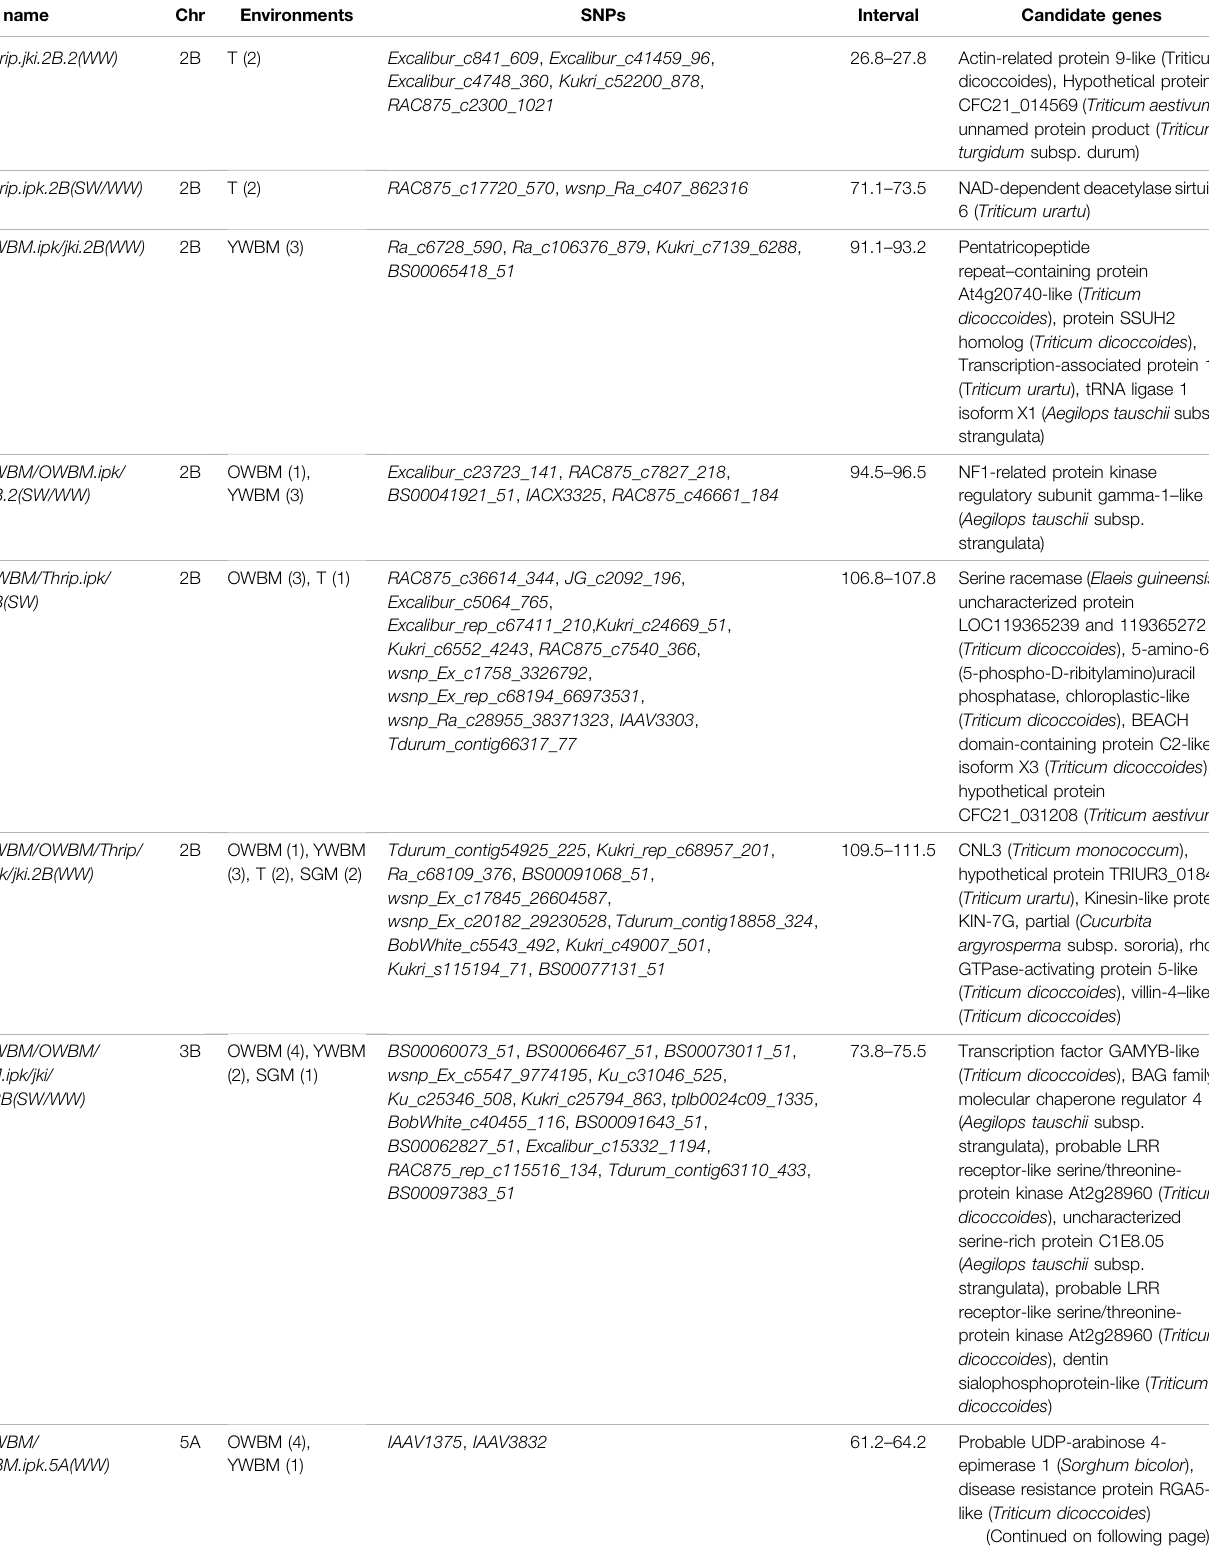
TABLE 5 | ( Continued ) QTLs with SNPs in association with various pests in multiple